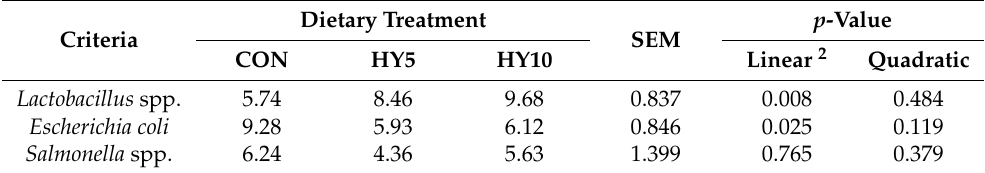
Table 8. Microbial counts (log cfu/g feces) of early weaned piglets fed HY-supplemented diet 1 . Dietary Treatment Criteria Lactobacillus